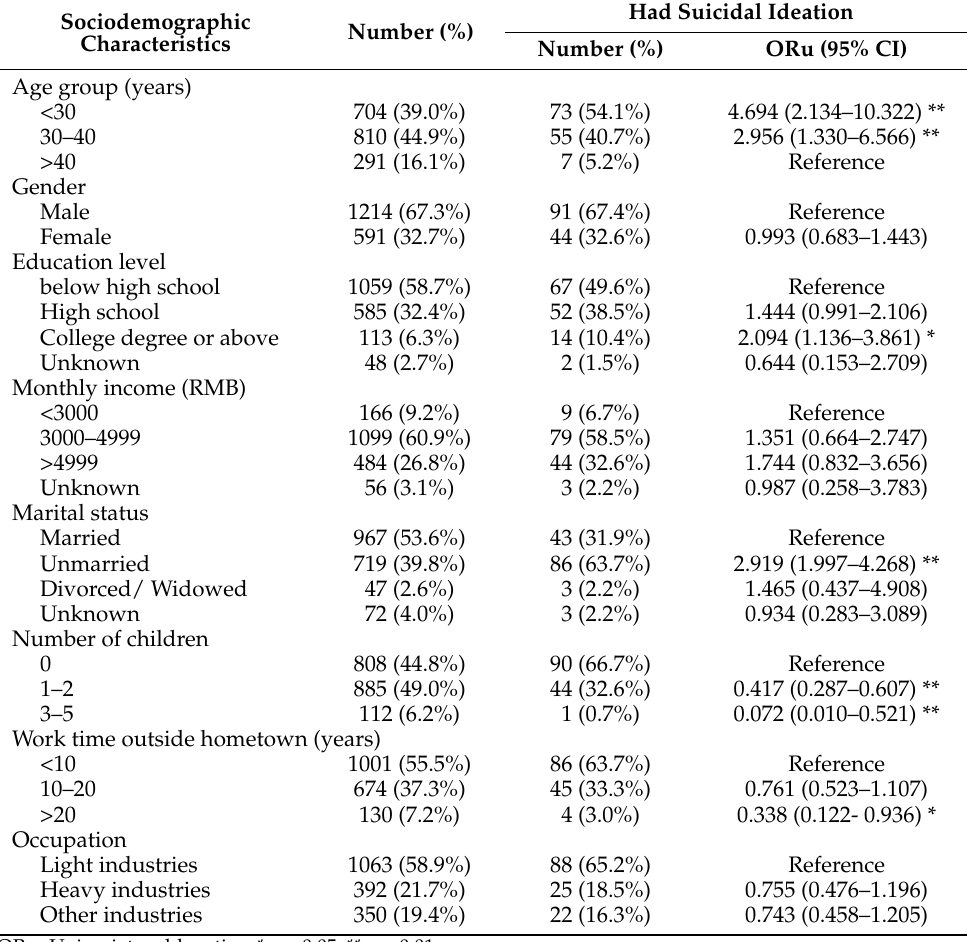
Table 1. Sociodemographic characteristics and their association with suicidal ideation. Sociodemographic